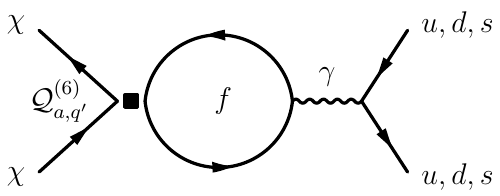
Figure 1 . Photon penguin diagrams that induce mixing of DM vector interactions with leptons or heavy quarks into DM vector interactions with light quarks. Here, f = u; d; s; c; b; e; (cid:22); (cid:28) can denote any of the quarks or charged leptons.